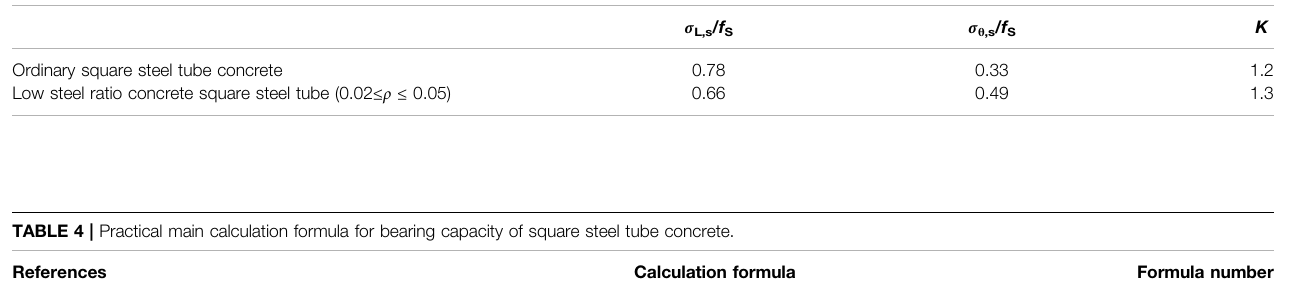
TABLE 3 | Relationship between axial (transverse) stress and yield strength of steel tubes.